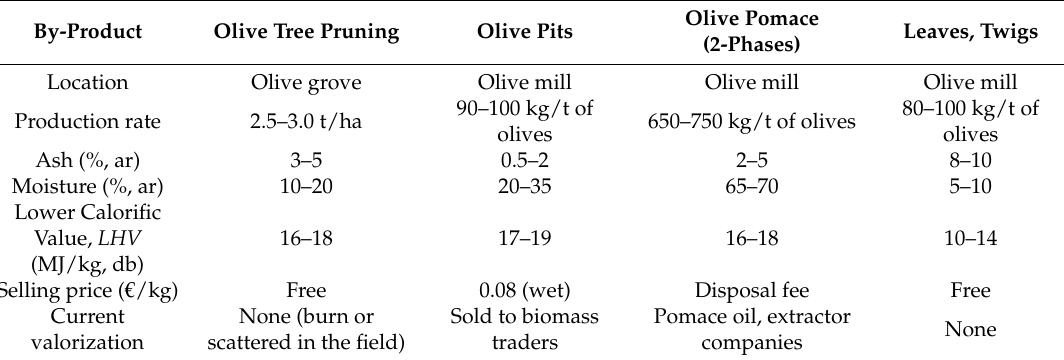
Table 1. Main properties and current applications of the olive oil industry by-products.